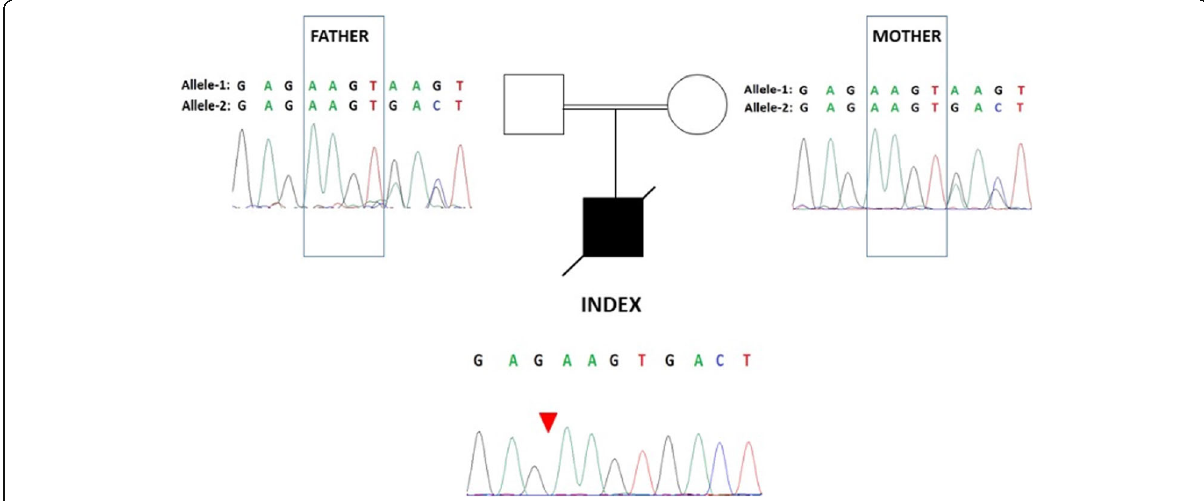
Fig. 4 Electropherogram of the index and his